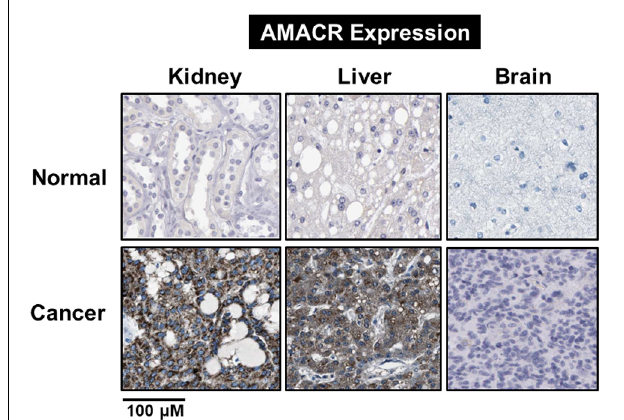
FIGURE 7 | Identification of AMACR expression in normal and cancer cells. Expression of AMACR detected by immunohistochemistry in normal and cancer cells. High expression levels of AMACR were confirmed in kidney, liver, and brain cancer. Scale bars represent 100 µ M. The representative images are from Protein-atlas projects [adapted from Uhlen et al. (2017)].